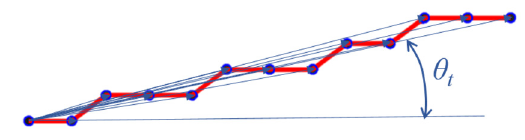
Figure 6. Angle of luminescent mini-tuft.